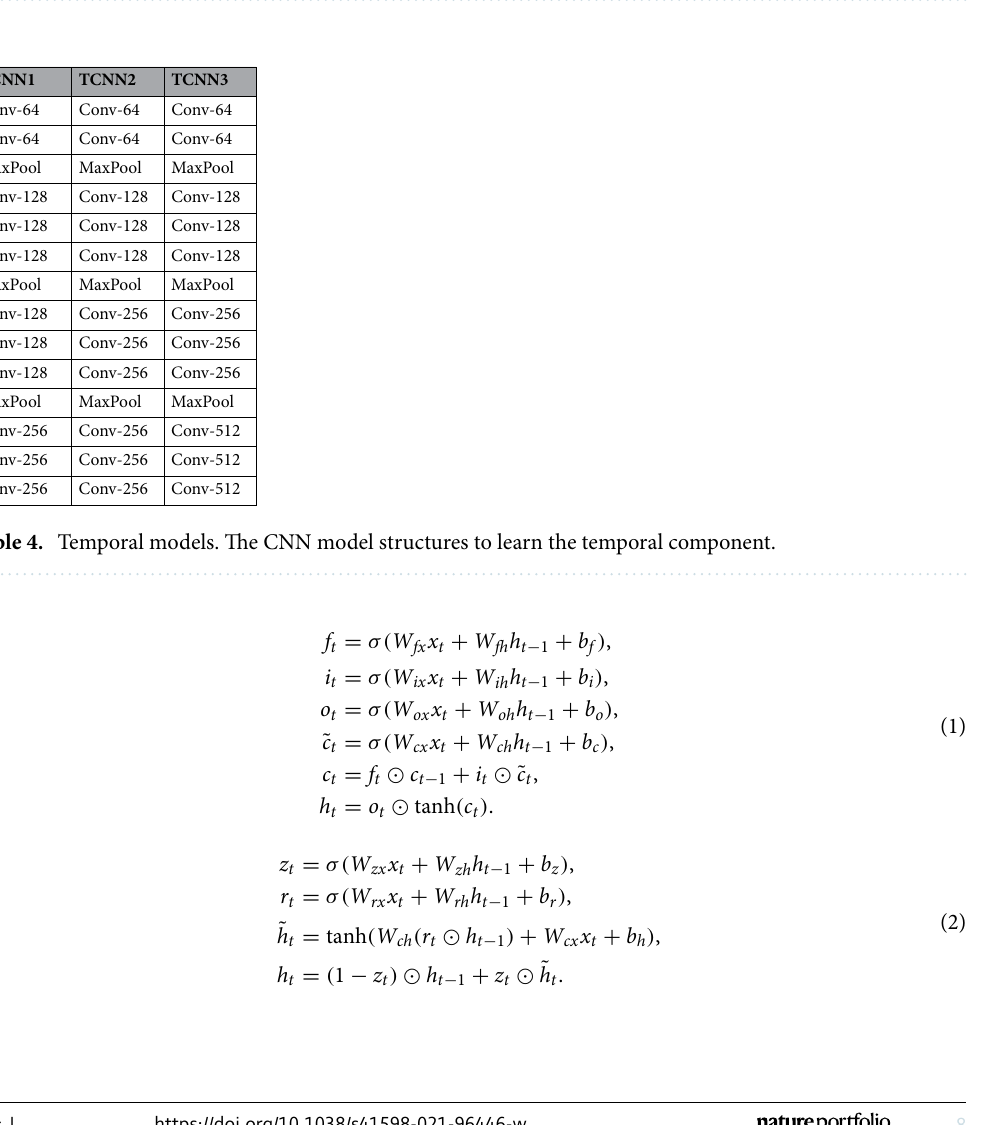
Table 3. Representation models. The model structures of the three CNNs used for representation.